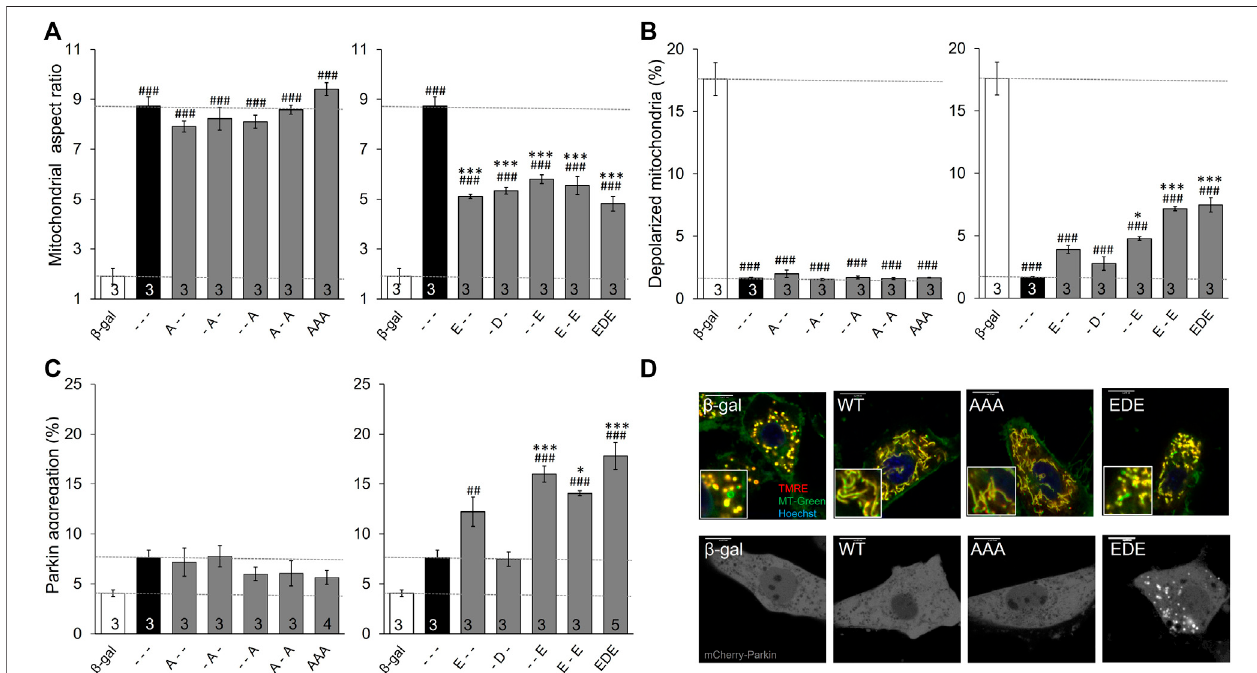
FIGURE2| IntrinsicfunctioningofindividualandcombinatorialMFN2PINK1phosphorylationsitemutantsexpressedin Mfn1/Mfn2 doubleknockoutMEFs.MFN2 mutants designated as in Figure 1A were expressed by adenoviral transduction of Mfn1/Mfn2 double null murine fi broblasts. Adeno β -gal was negative control; --- indicates no mutation at T111, S378 or S442 (i.e., WT MFN2). (A) Mitochondrial aspect ratio. (B) Mitochondrial depolarization. (C) Parkin recruitment. Results for phosphorylation-defective (A substitutions) and phosphorylation mimic (E or D substitutions) are separated for clarity; β -gal and --- are duplicated for comparison. (D) Representative confocal images. Nshown isnumber ofindependent experiments. Mutant vs. adeno WTMfn2: p < 0.05*; p < 0.01**; p < 0.001***; MFN2 vs.adeno β -gal: p < 0.05 #; p < 0.01 ##; p < 0.001 ###, all by ANOVA. Error bars are